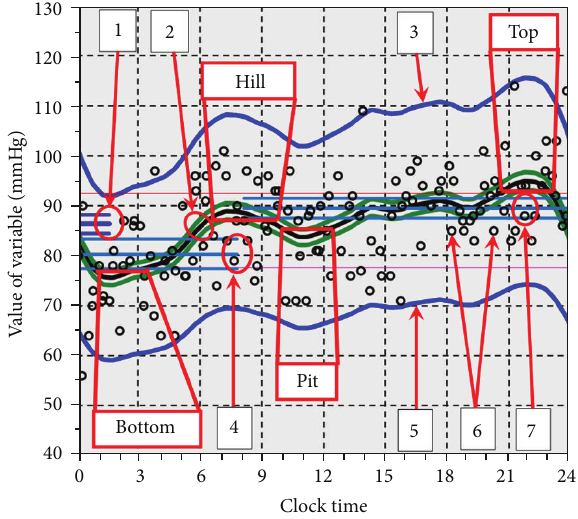
Figure 6: Main features of signal profile. Abscissa: time, ordinate: values of variable. 1: general mean level, 2: approximating curve (profile), 3: upper confidence limit of population, 4: mean level of night values, 5: lower confidence limit of population, 6: separate records, 7: Mean level of night values. Top: highest area of the process, Bottom: lowest area of the process, hill: intermediate eleva- tion, pit: intermediate decrease. Red horizontal bars at those areas: confidence limits of their timing. Hills and tops are shown only if they are statistically significant comparing with the neighboring areas. Ovals include value of parameter and its confidence